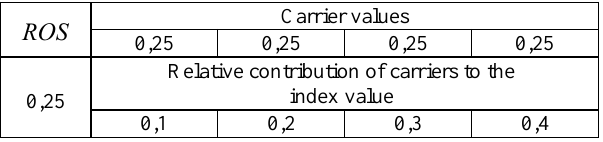
Table 1. A relative contribution of attribute carriers to ROS value, when